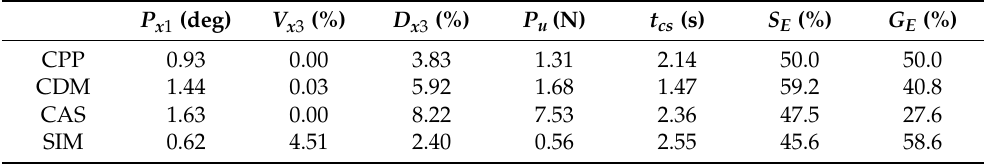
Table 3. Controller performance comparison using linearized CIP model.